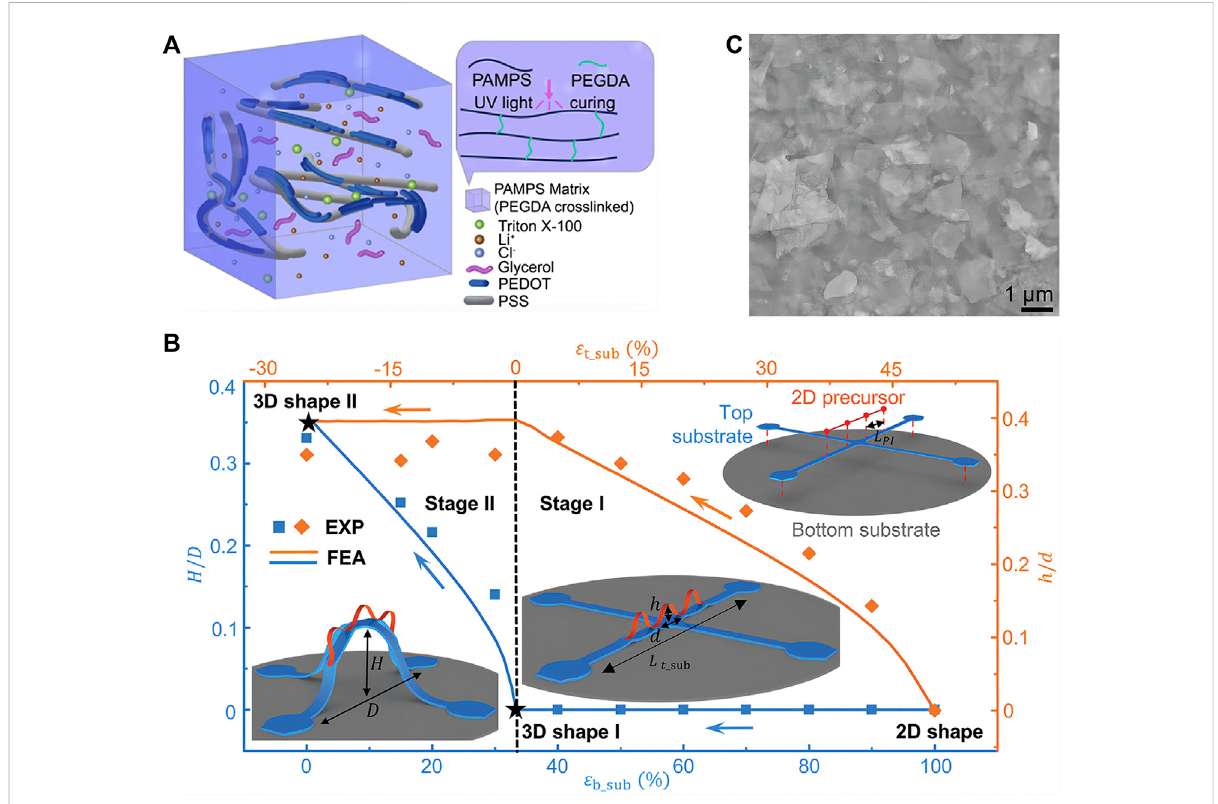
FIGURE 2 Advanced tissue-like materials for skin electronics (A) The schematic diagram of the polymer-hydrogel EEG electrode matrix. Polyethylene glycol diacrylatewasusedasacross-linkerfortheformationofhydrogel.Reproducedwithpermissionfromref(Hsiehetal.,2022).Copyright2022Elsevier (B) Arepresentativesetof3Dmesostructuresformedbymechanicallyguidedhierarchicalassemblyanddependenceoftheirgeometriesonvariousdesign parameters. Reproduced with permission from ref (Zhao et al., 2022). Copyright 2022 Wiley (C) SEM images showing VDWTFs assembled from staggered 2D nanosheets. Scale bar, 1 μ m. Reproduced with permission from ref (Yan et al., 2022). Copyright 2022